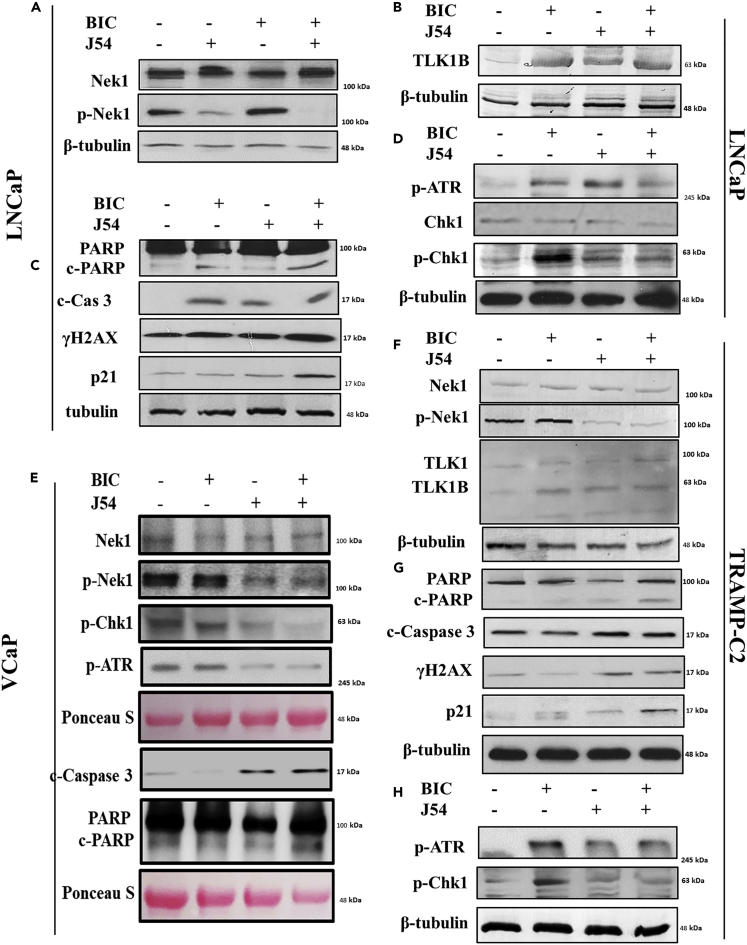
J54 in Combination with Bicalutamide Suppresses the Checkpoint Activation Markers and Induces Apoptotic MarkersWestern blots (WB) of cell cycle and apoptotic indicators. (A–D) LNCaP, (E) VCaP, and (F–G) TRAMP-C2 cells from the four treatment groups as indicated were analyzed by WB for several indicators of DNA damage/apoptosis and mediators of cell-cycle arrest. Representative analysis of two independent experiments for each cell line is shown.